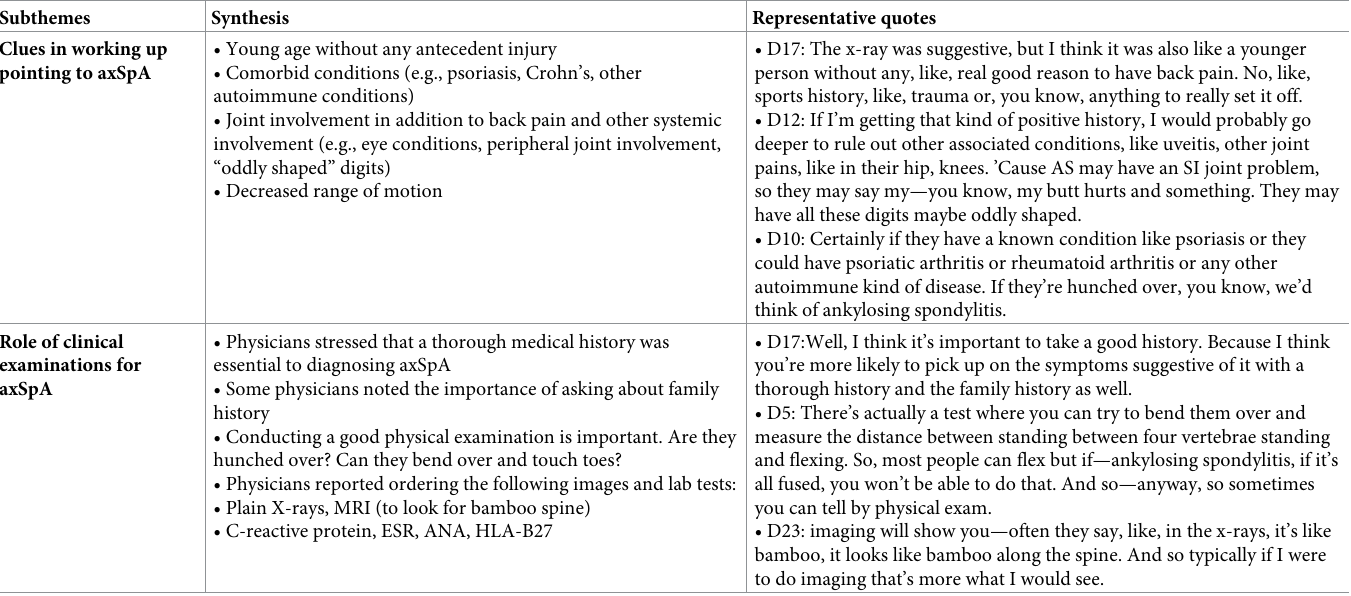
Table 3. Synthesis of physician work-up of axial